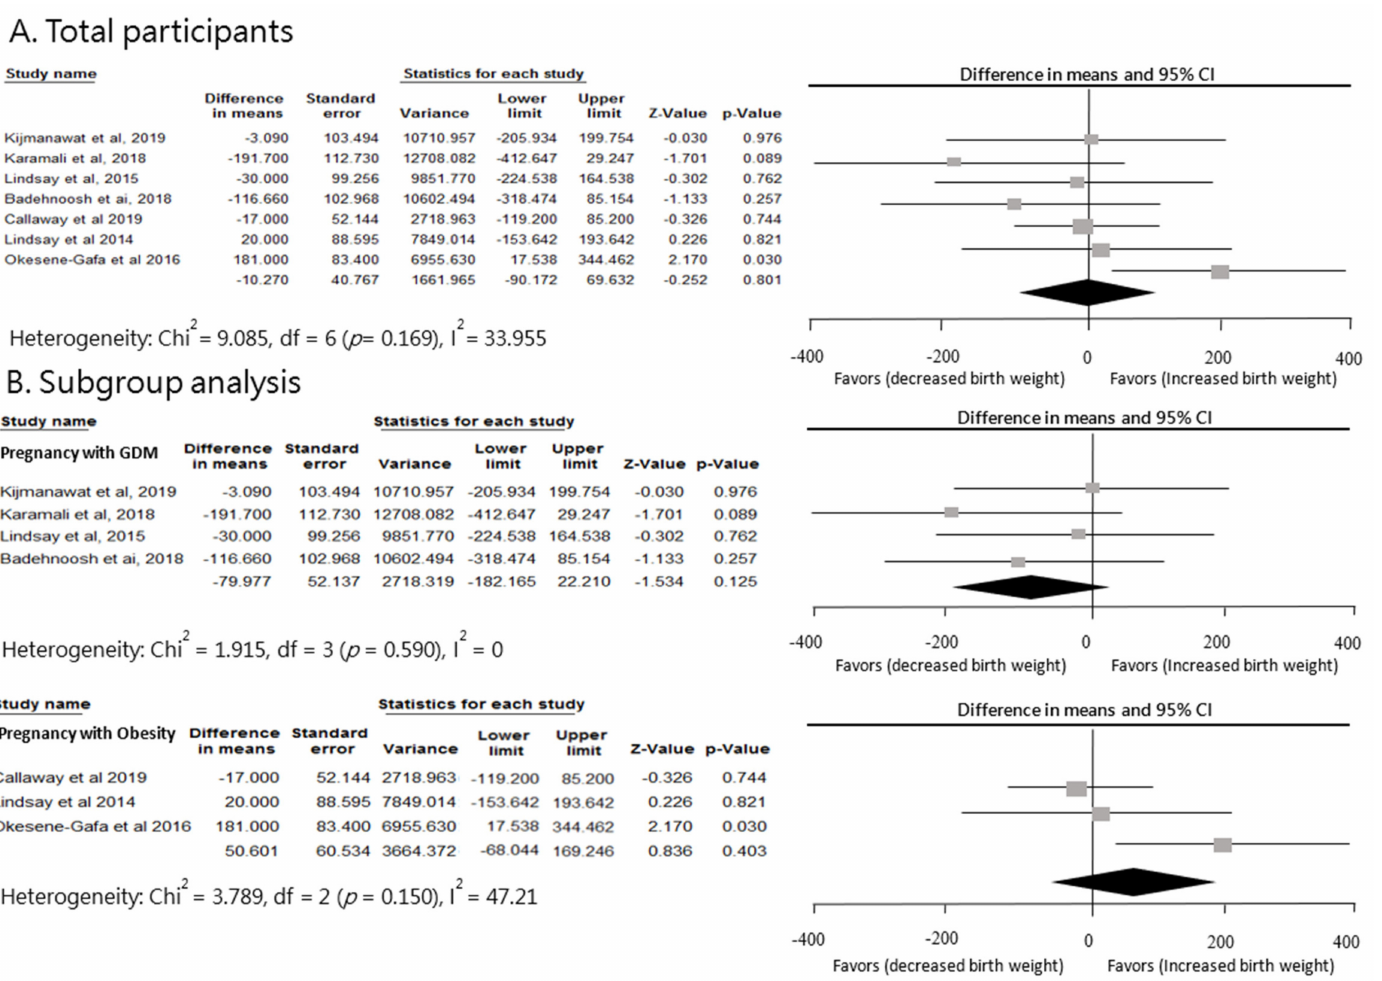
Figure 3. E ff ect of probiotic supplementation on newborn birth weight (g) in pregnant women with GDM or